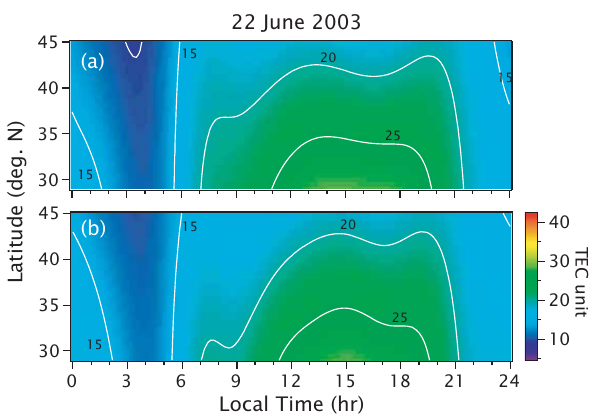
Fig. 6. Same as Fig. 5 but for June solstice 2003.